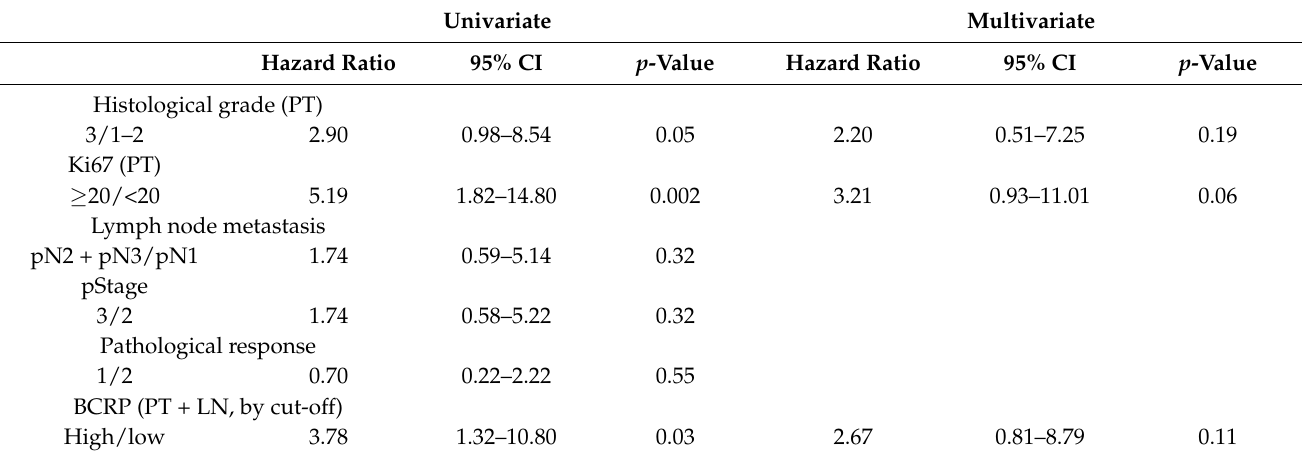
Table 4. Univariate and multivariate analyses of influencing factors of overall survival ( n = 37). Univariate Multivariate Hazard Ratio 95% CI p -Value Hazard Ratio 95% CI p